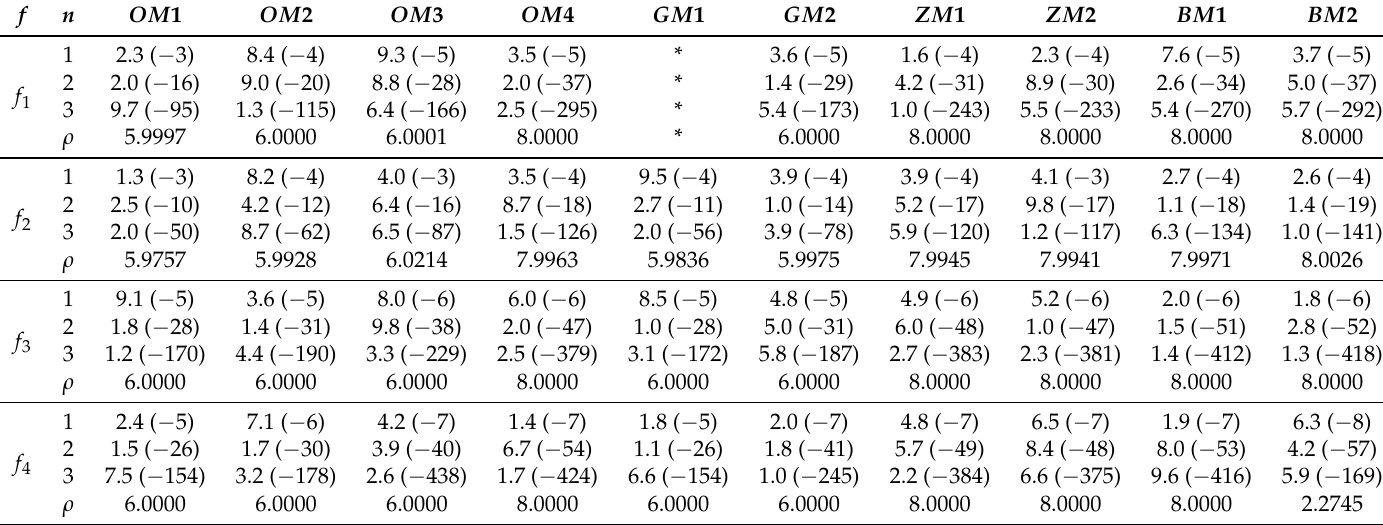
Table 1. Comparison on the basis of the difference between two consecutive iterations | x n + 1 − x n | for the functions f 1 – f 4